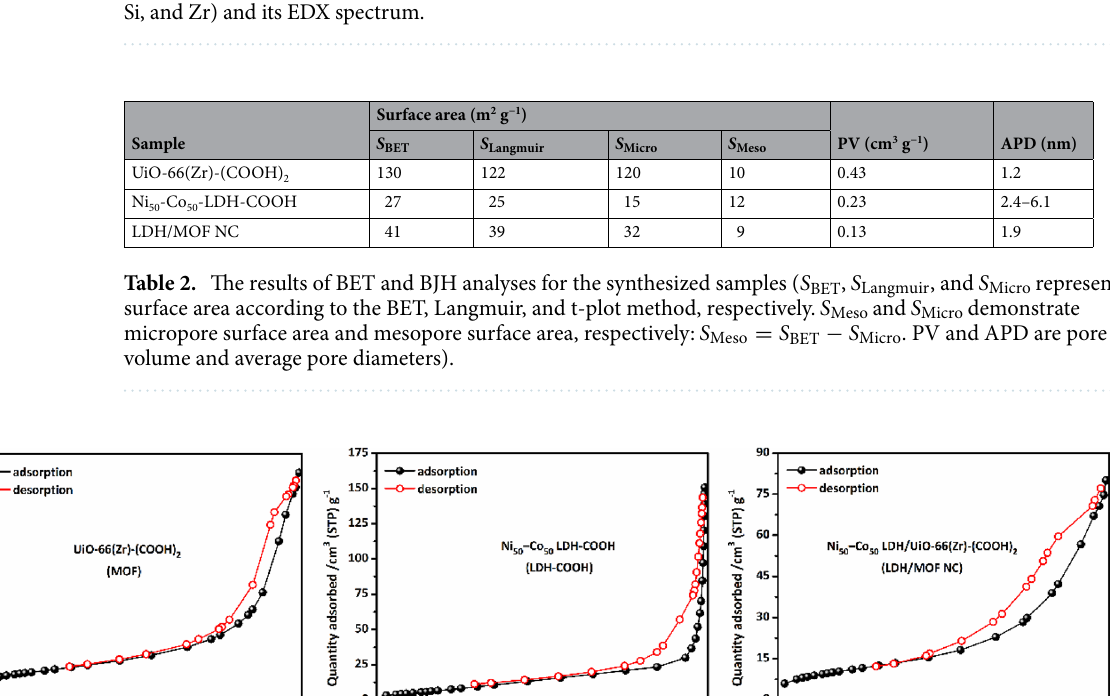
Figure 3. FESEM-EDX mapping images of LDH/MOF NC and the corresponding elements (Co, Ni, O, C, N, Si, and Zr) and its EDX spectrum.